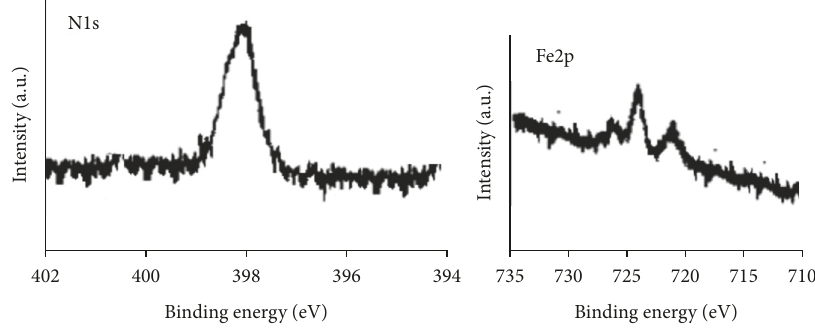
Figure 5: XPS spectra of Prussian blue